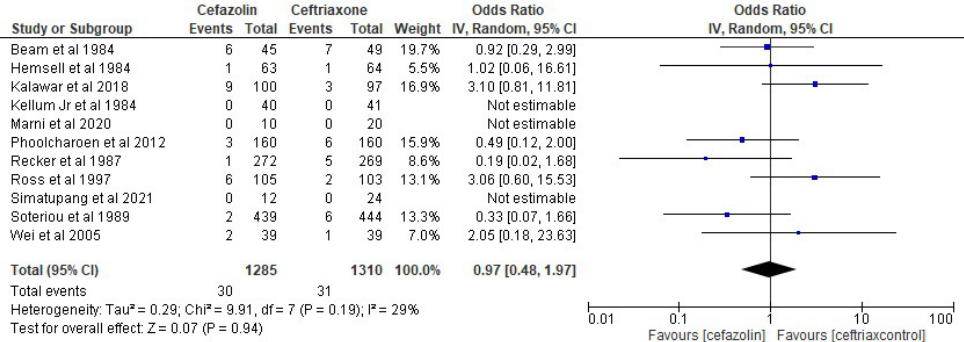
Figure 4. The rate of SSIs in the cefazolin group vs. ceftriaxone group. The included studies were